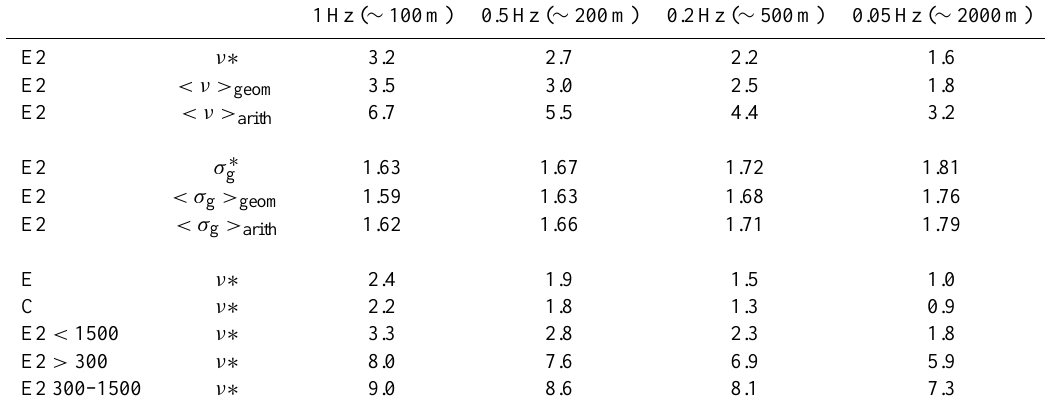
Table 1. Values of ν ∗ and σ ∗ g , the arithmetic mean ( ν arith , σ garith ) and geometric mean ( ν geom σ geom ) of the ensemble of shape parameter values, as well as values of ν ∗ for spectra reconstructed using the center-in (C) method, entire-in method (E) and spectra truncated above 1500µm ( < 1500), under 300µm ( > 300) and both (300–1500). All values are given for four resolutions: 1, 0.5, 0.2 and